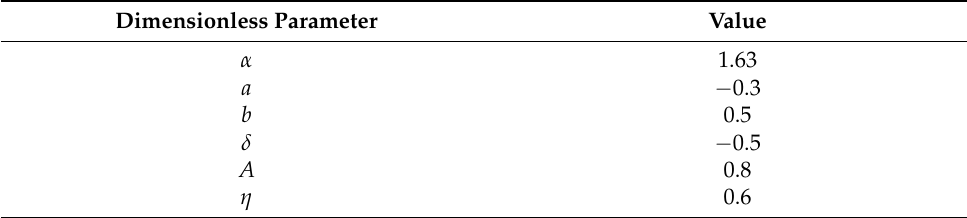
Table 1. Parameters and their